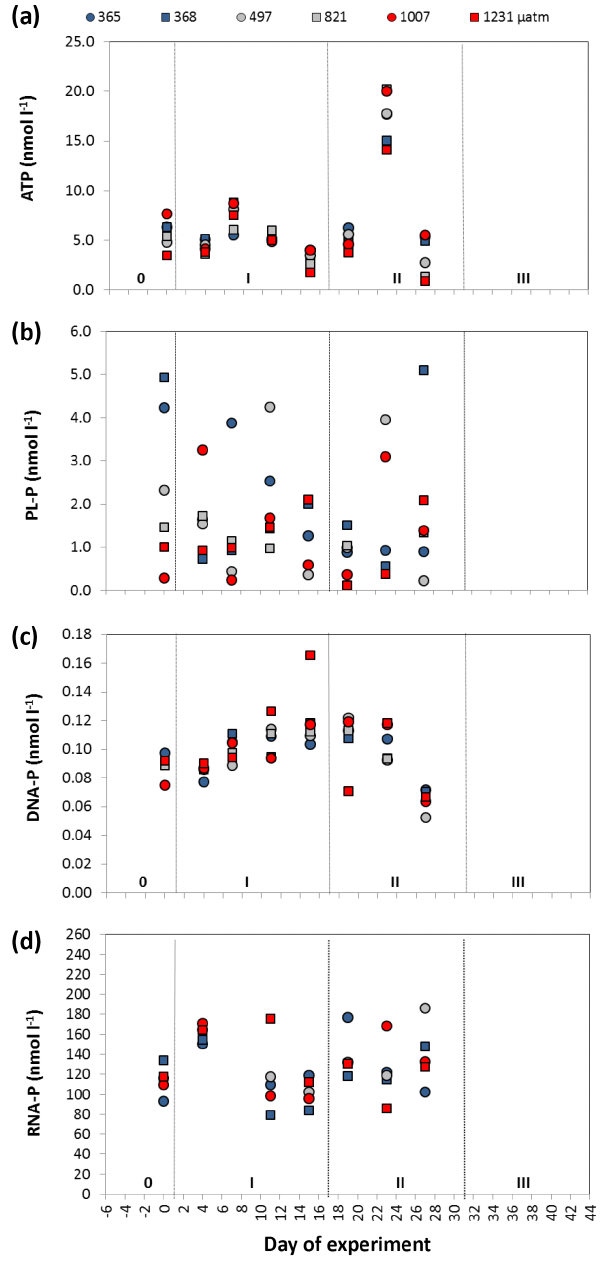
Figure 10. Development of DOP compounds in the mesocosms and in the fjord from day 0 to day